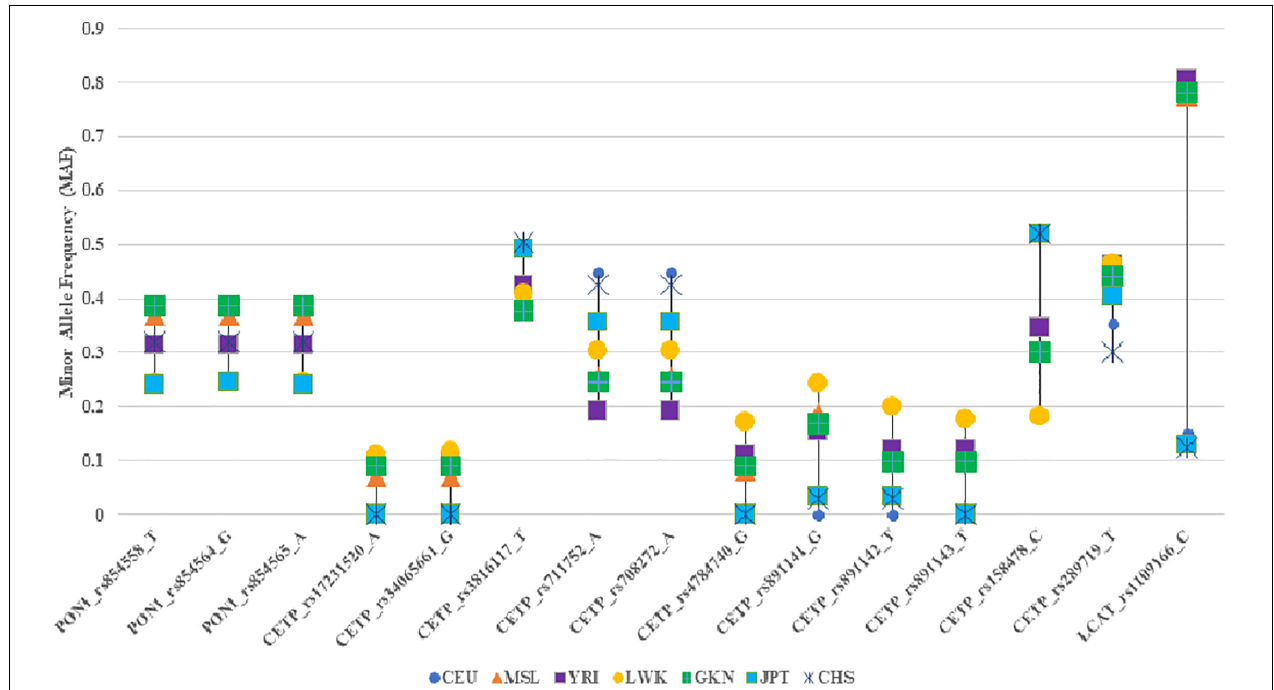
FIGURE 3 | Comparison of the minor allele frequencies of the significantly associated SNPs in the study population with those of the 1000 Genomes. CEU: Northern Europeans from Utah, MSL: Mende in Sierra Leone, YRI: Yoruba in Ibadan, Nigeria, LWK: Luhya in Webuye, Kenya, GKN: the study population, JPT: Japanese in Tokyo, Japan, CHS: Southern Han